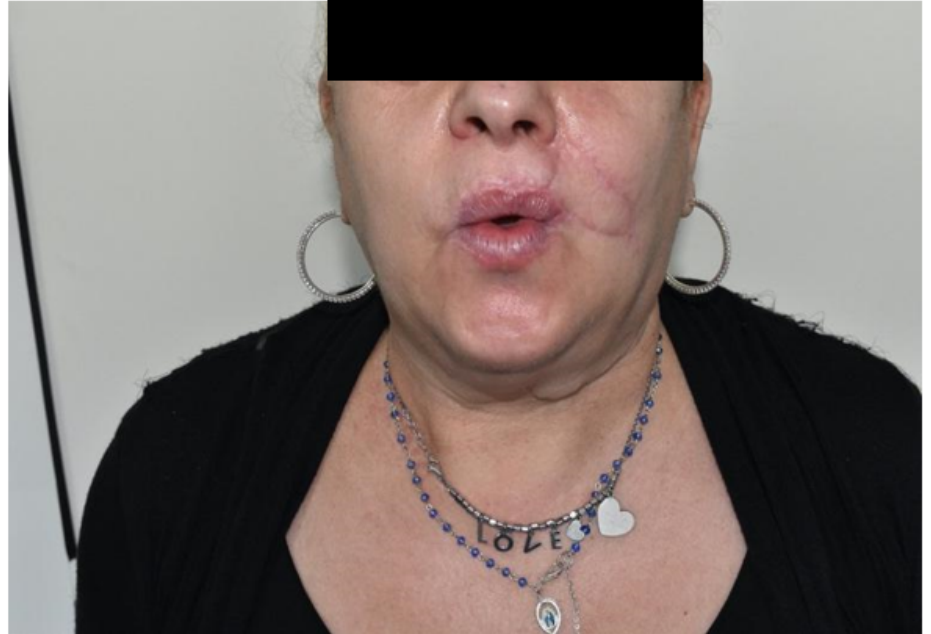
Figure 16. Case 6: Follow up at 6 months after surgery. Sphincteric muscle function, frontal view.